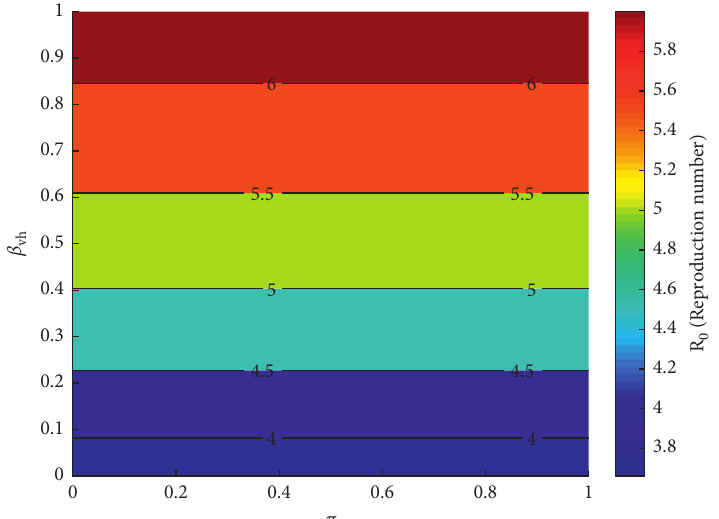
Figure 13: The contour plot of the basic reproduction number as a function of the vertical transmission rate ( π ) and human-to-vector transmission rate ( β hv )